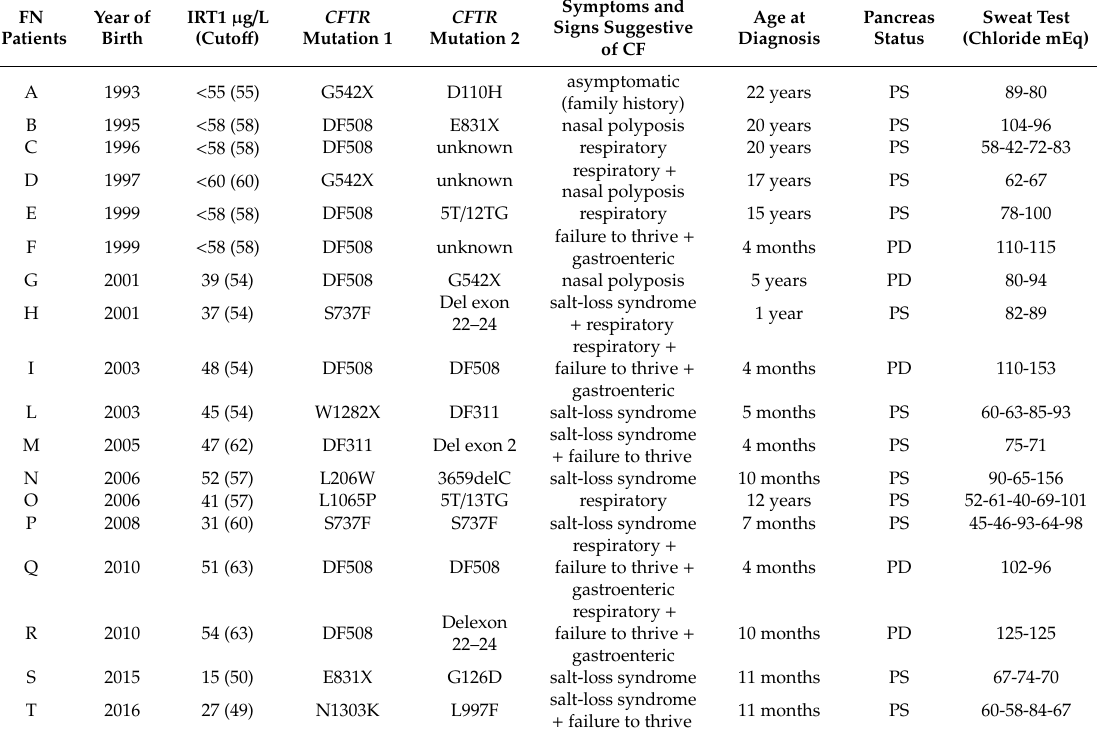
Table 2. Features of false-negative (FN) patients: genotype, symptoms, first immunoreactive trypsinogen dose (IRT1), age at diagnosis, pancreas status, and sweat test. FN